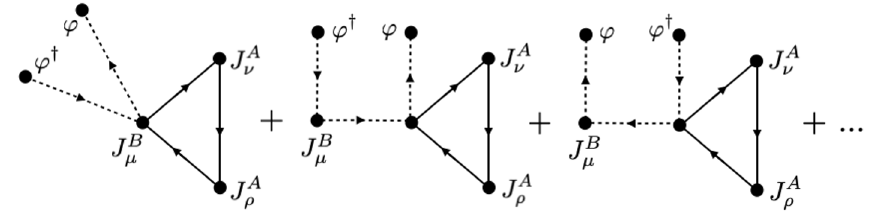
Figure 3 . Triangle diagrams proportional to q B entering the correlator in eq. (A.1) in the unbroken ϕ phase (the + . . . refers to the same diagrams with the orientation of the fermionic arrows reversed). Solid lines are fermion propagators and dashed lines are scalar